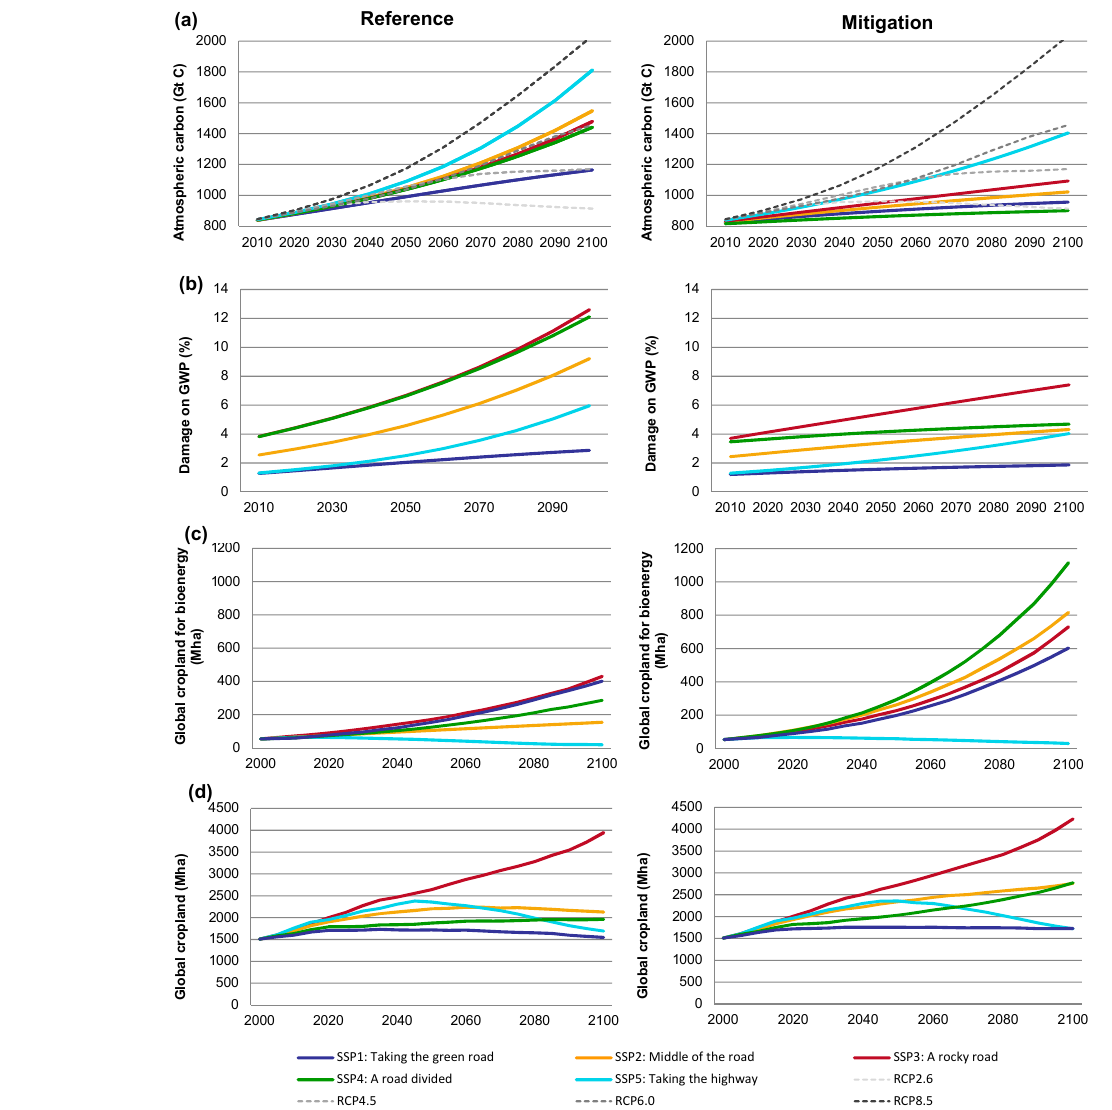
Figure 4. (a) Atmospheric carbon (GtC) including carbon trajectories (GtC) for the four RCPs, (b) corresponding damage to GWP (%), (c) global cropland for bioenergy (Mha) and (d) global cropland, including cropland for bioenergy (Mha) for reference and mitigation